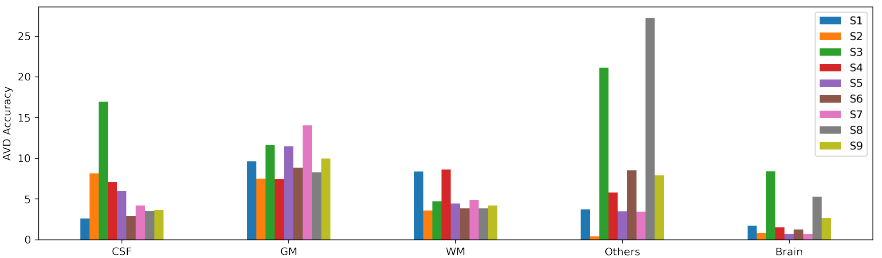
Figure 10. Accuracy per subject of our segmentation framework utilizing the percentage absolute volume difference (AVD(%))